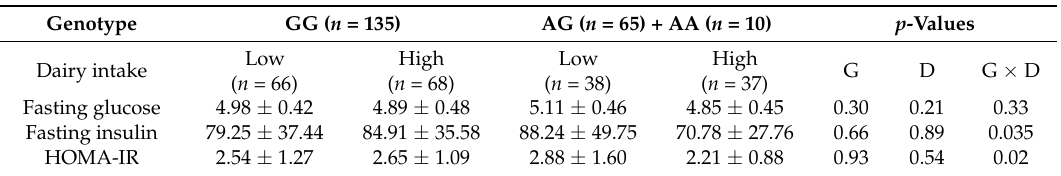
Table 2. Effect of the interaction between rs1799884 and dairy intake (median: 2.17 portions/day) on glucose-related parameters.